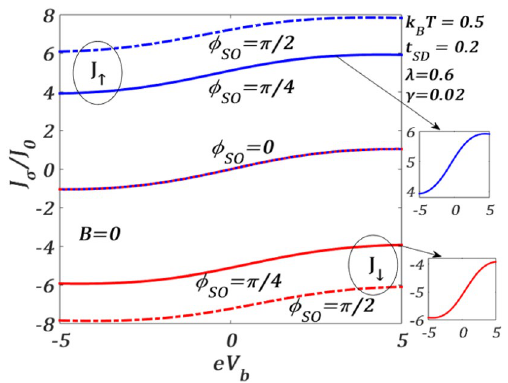
Figure 2. Spin-resolved current J σ / J 0 versus eV b for different values of φ SO for k B T 0 . γ = 0.02 at B =